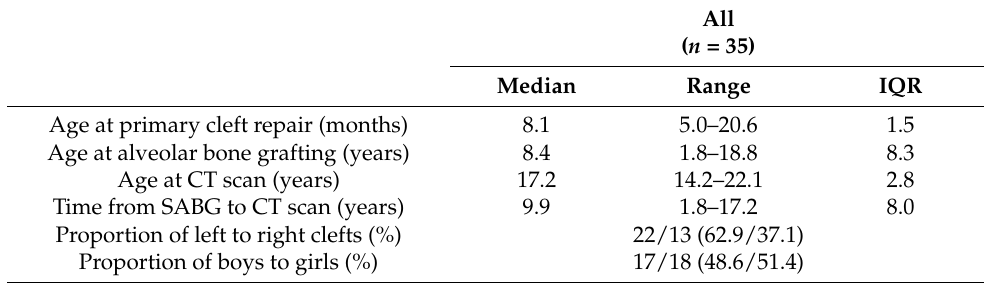
Table 1. Demographic and clinical characteristics of the study group. IQR-interquartile range. SABG—secondary alveolar bone